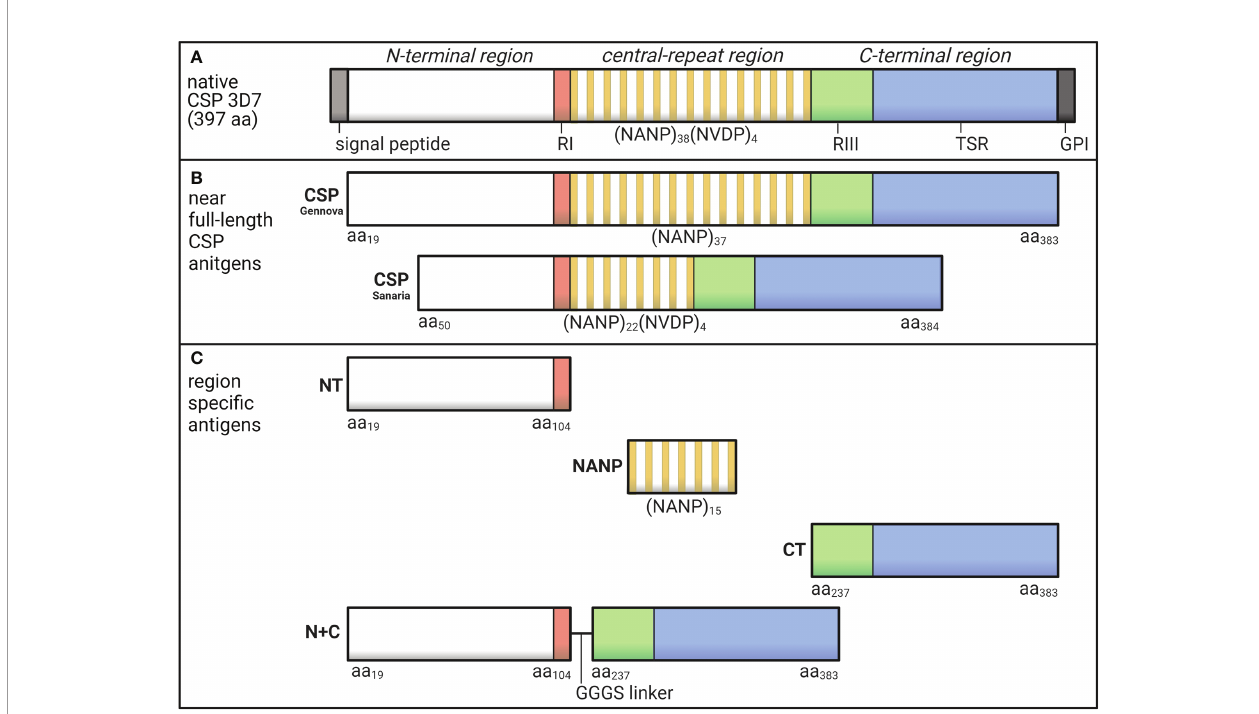
FIGURE 1 | Schematic of P. falciparum CSP and region-speci fi c antigens used in this study. (A) Native P. falciparum CSP (3D7) is 397 amino acids in length and can be divided into the N-terminal region that contains Region I (RI), the central-repeat region largely comprised of NANP tandem repeats, and the C-terminal region that includes Region III (RIII) and the thrombospondin type 1 repeat (TSR) domain. (B) In this study, we used two near full-length CSP antigens that lacked the signal peptide and GPI sequences from Gennova (expressed in E. coli ) and Sanaria (expressed in P. pastoris ) in human and rabbit studies, respectively. The Gennova CSP contained the major NANP motif repeated 37 times, and the Sanaria CSP began at amino acid 50 and contained the major NANP motif repeated 22 times and the minor NVDP motif repeated 4 times. (C) We also used region-speci fi c antigen constructs including a peptide representing the N-terminal region between amino acids 19-104 (NT), a peptide representing the central-repeat region comprised of the NANP motif repeated 15 times (NANP), recombinant protein representing the C- terminal region between amino acids 273-383 (CT) and a truncated form of CSP generated by the N-terminal and C-terminal regions fused together via a GGGS short linker (N+C). See Table 1 for full details. Created using